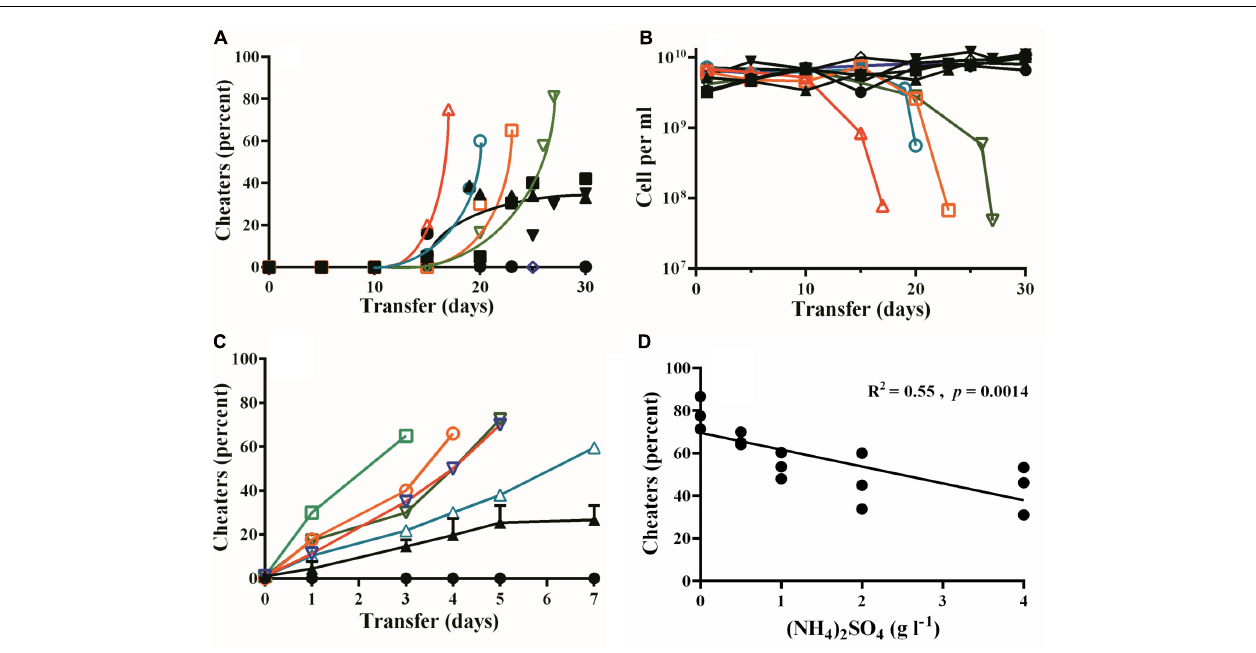
FIGURE 1 | Emergence of LasR-mutant cheaters and their fitness in PM-casein with or without ammonium sulfate added. (A) Percent of protease-negative cheaters in PM-casein media over time. In four of five individual experiments without added ammonium sulfate, cheaters emerged and increased (hollow symbols). In PM-casein with ammonium sulfate (black symbols), cheaters reached a frequency of 27 ± 7%. In one experiment with and one experiment without ammonium sulfate, cheaters did not emerge. (B) Cell densities in casein experiments. In the cases where the culture could not be propagated, the final cell densities fell by 90–99% (hollow symbols). Experiments in PM-casein with ammonium sulfate (black symbols) are shown for comparison. (C) LasR-mutant frequency after 7 days of passage. LasR-mutant cheater frequency in PM-casein without ammonium sulfate was rapid in all five replicates from an initial frequency of 1% (hollow symbols). An equilibrium was always established (black triangles) in media with ammonium sulfate added. When LasR mutants were not present at the beginning of the experiment, they did not emerge in 7 days PM-casein with ammonium sulfate (black circles). (D) Outcomes of w.t. – LasR-mutant competitions with increasing ammonium sulfate concentrations. w.t. PAO1 and LasR-mutant cheaters were mixed at a 1:1 ratio and the frequency of each was enumerated after 24 h. Experiments were performed in triplicate. For the data in panel D , a linear regression analysis was